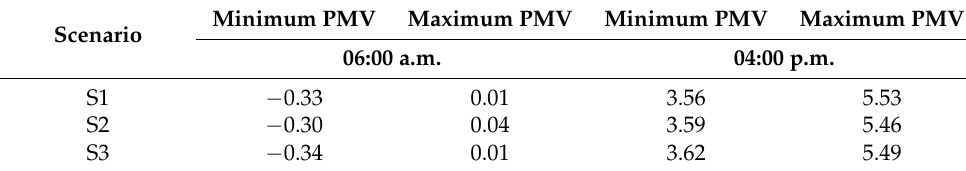
Table 6. Minimum and maximum PMV values at 06:00 a.m. and 04:00